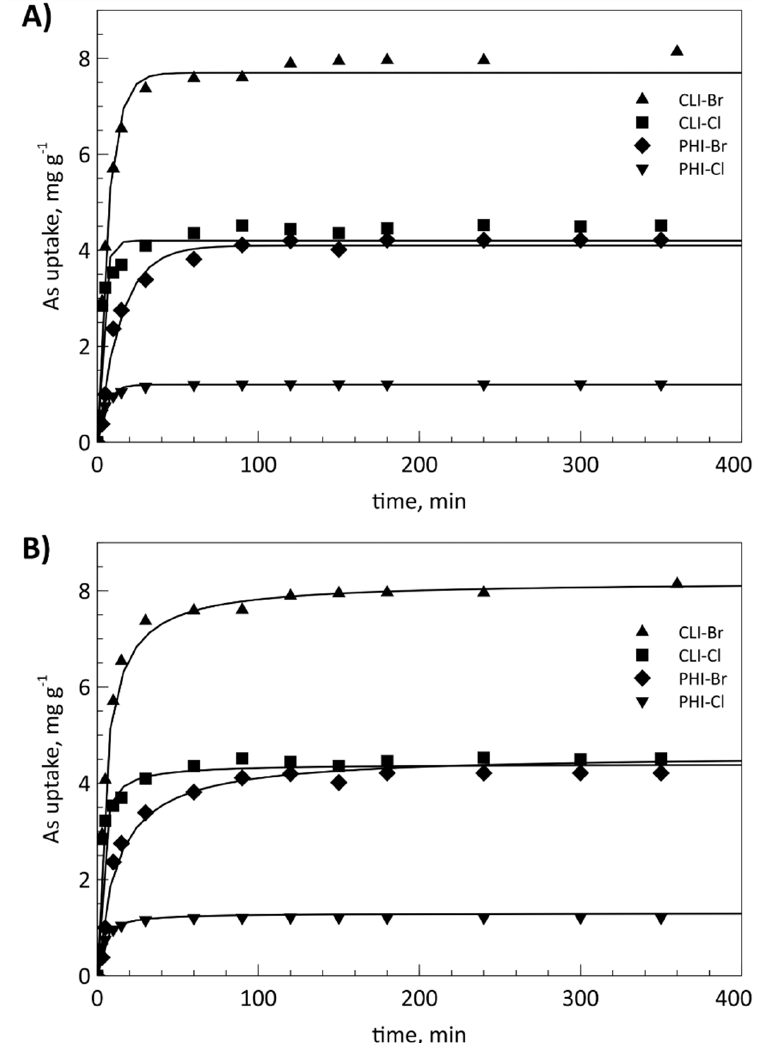
Figure 5. Fitting of the As kinetics with a pseudo-first order ( A ) and pseudo-second order equation ( B ). Table 3 . Kinetic parameters.